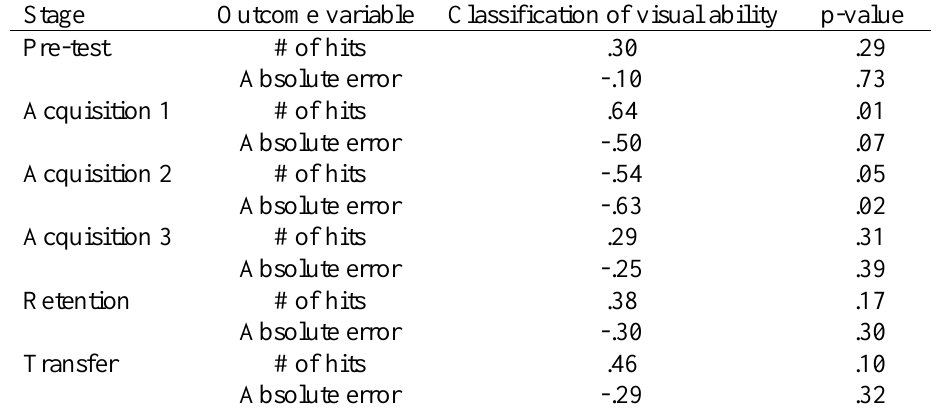
Table 1. Correlations (r) and statistical significance between the classification of visual ability and performance in all phases of the